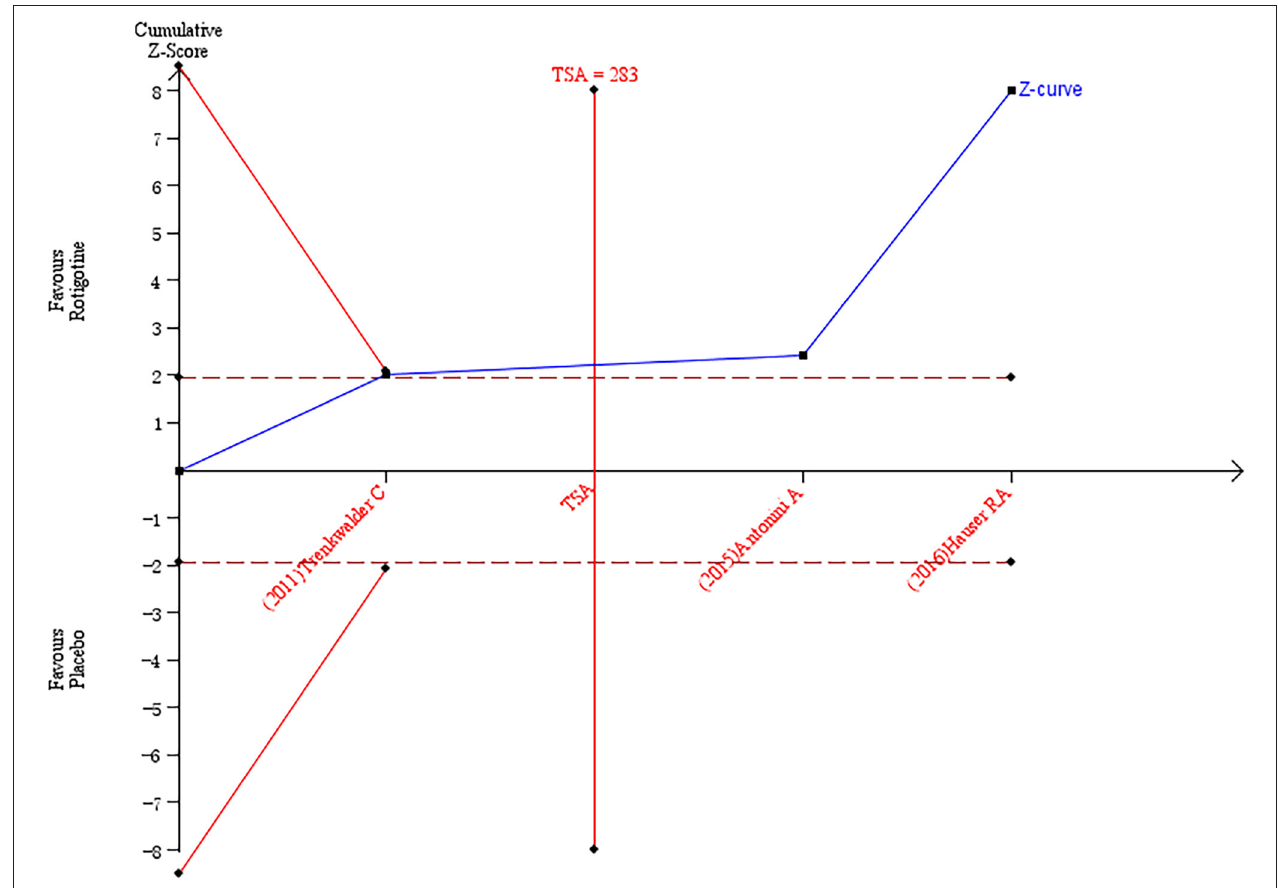
FIGURE 5 | Trial sequential analysis of the cumulative meta-analysis of the effect of rotigotine vs. placebo on Parkinson’s Disease Non-motor Symptom Assessment Scale total score in Parkinson’s disease patients.